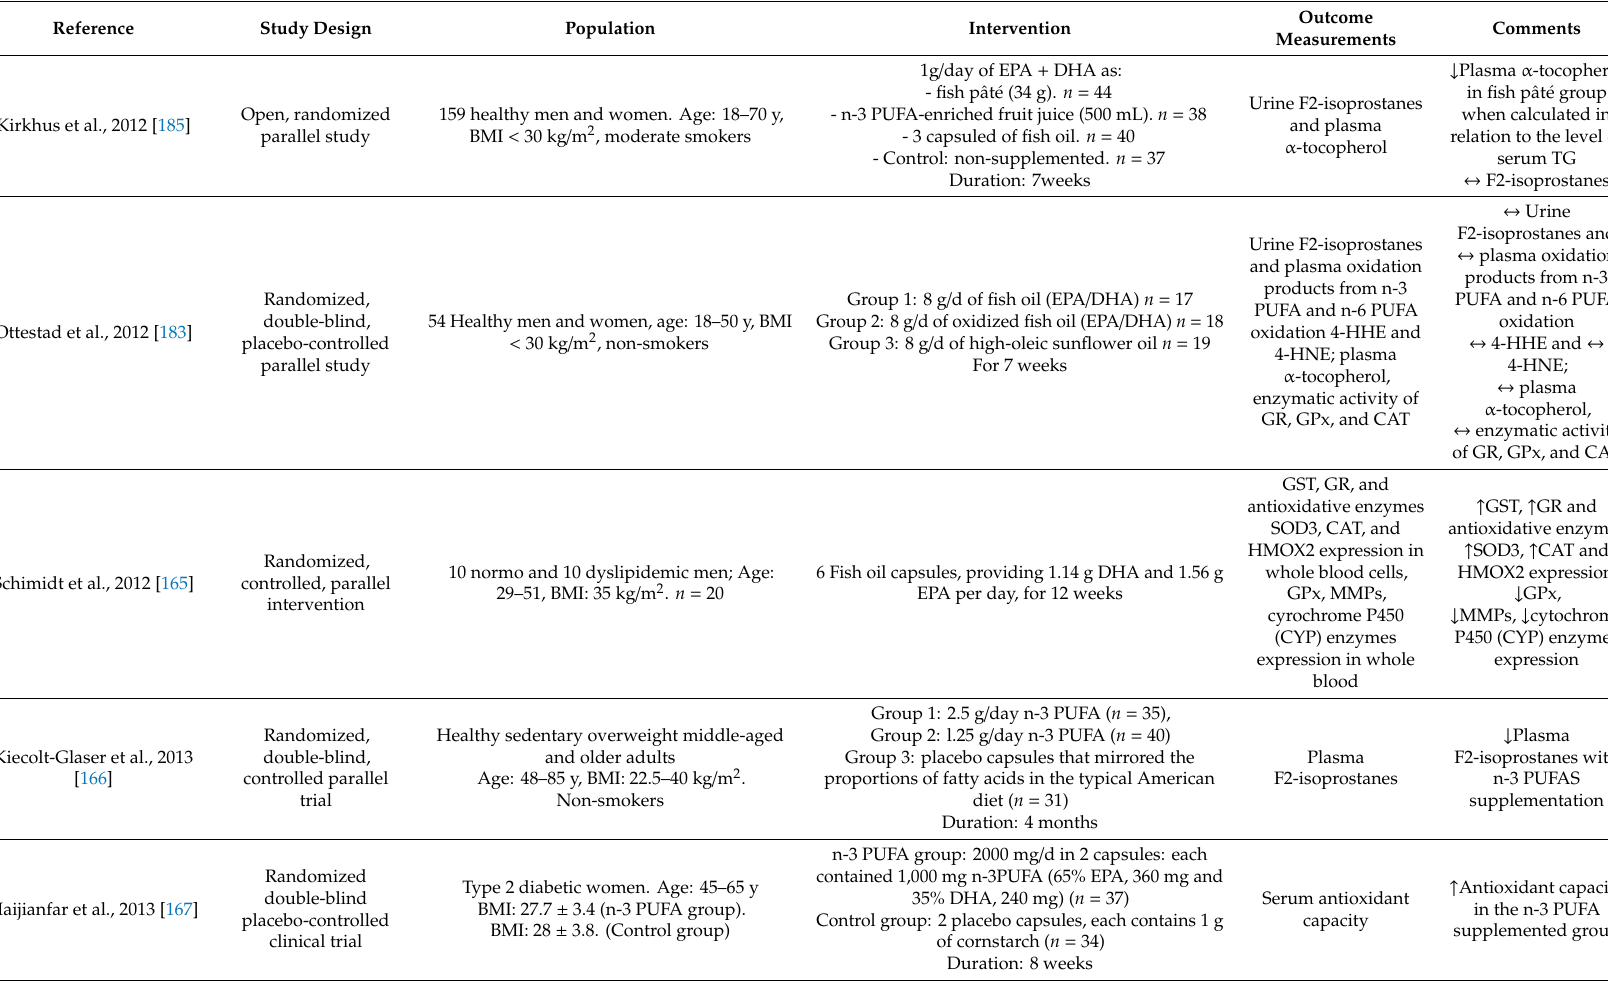
BMI: 28 ± 3.8. (Control